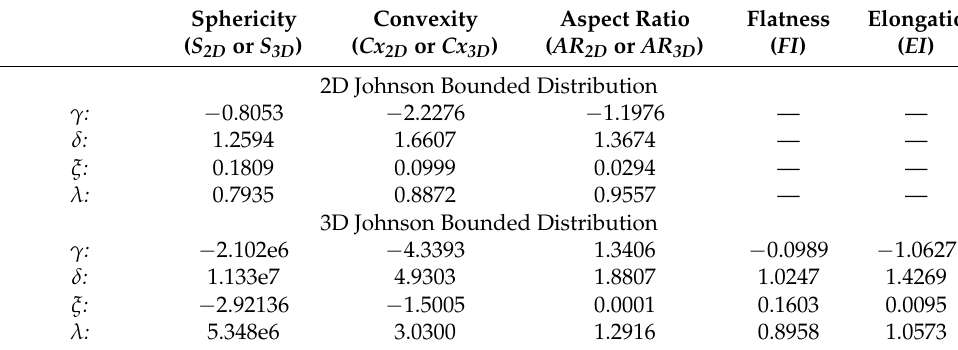
Table 4. Johnson Bounded Distribution fitting parameters.